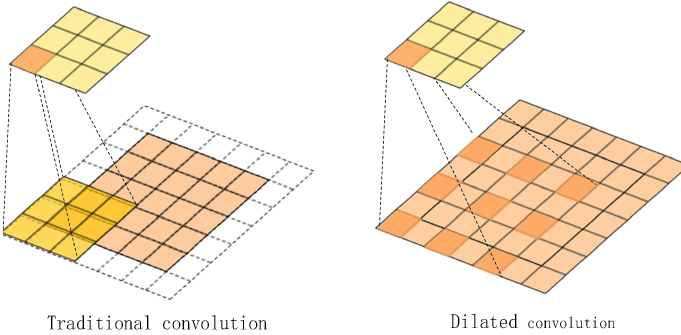
Figure 7. Comparison of traditional and expansive convolution.